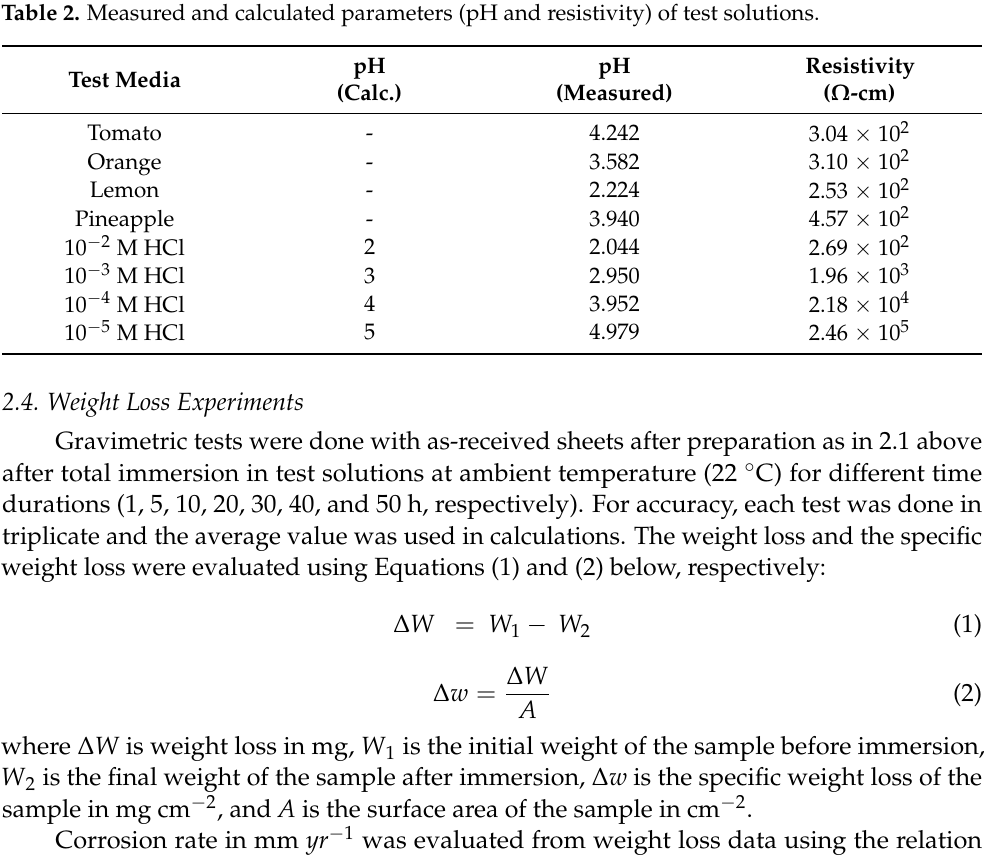
Resistivity ( Ω -cm)